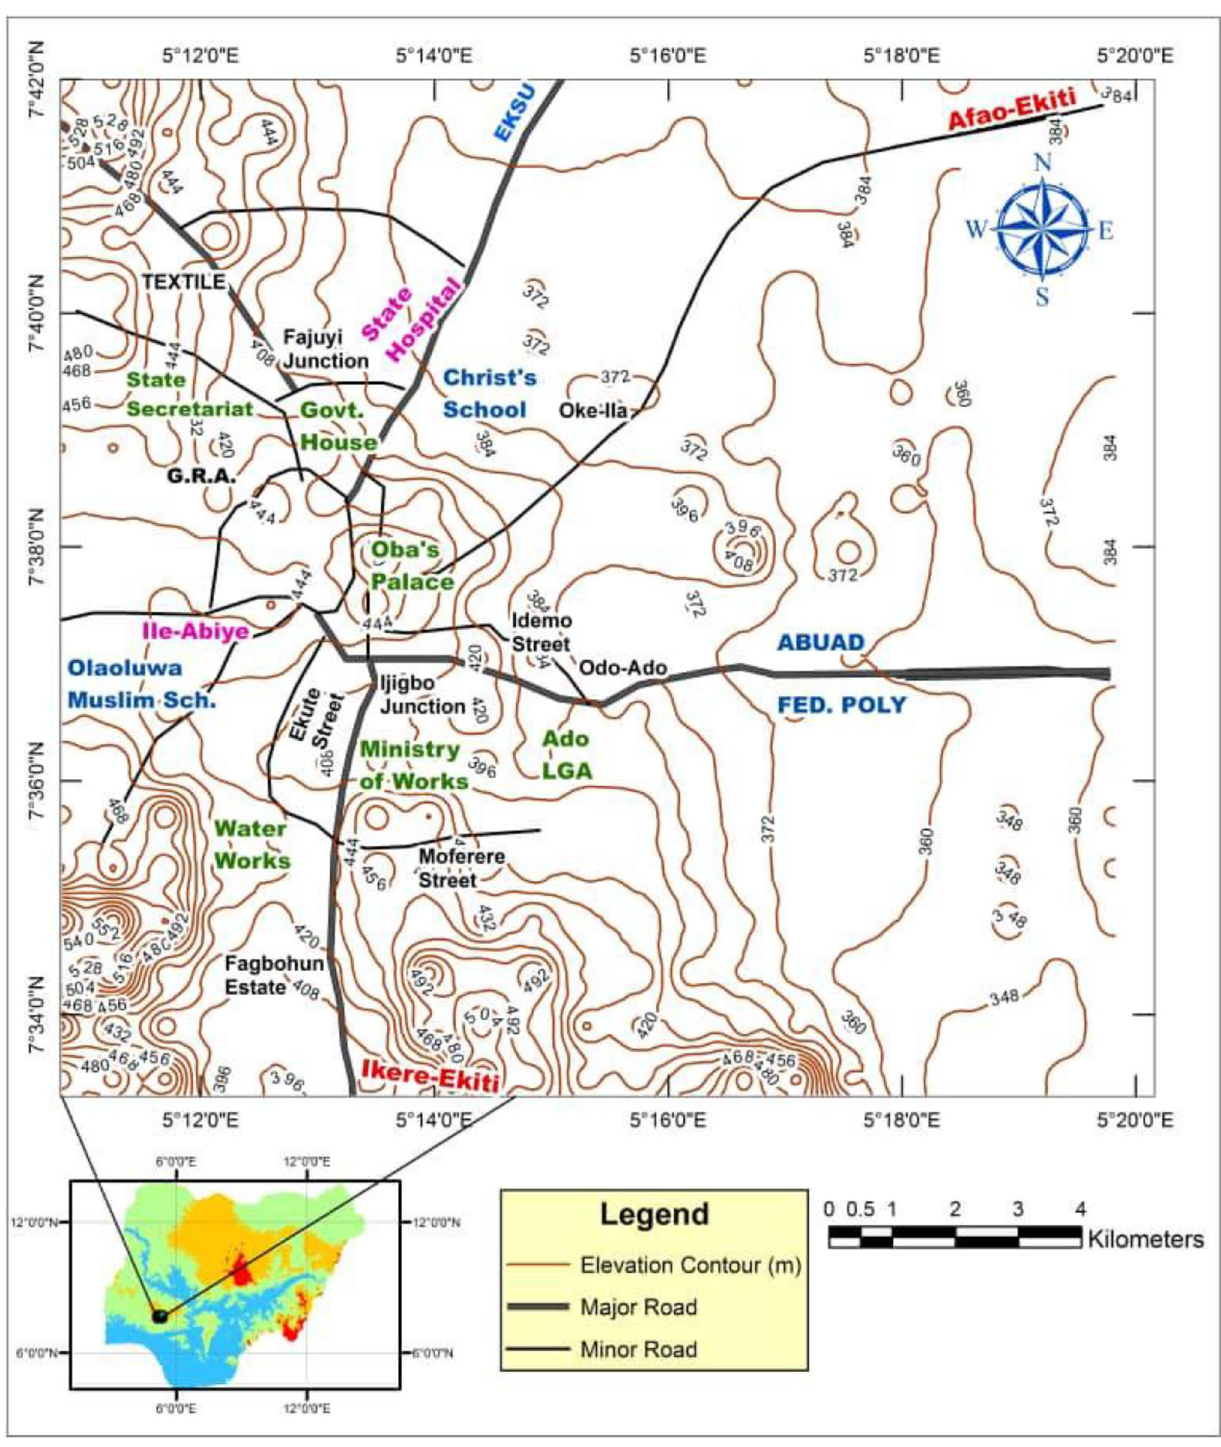
Fig. 2 Topographical map of Ado-Ekiti. Adapted from Google